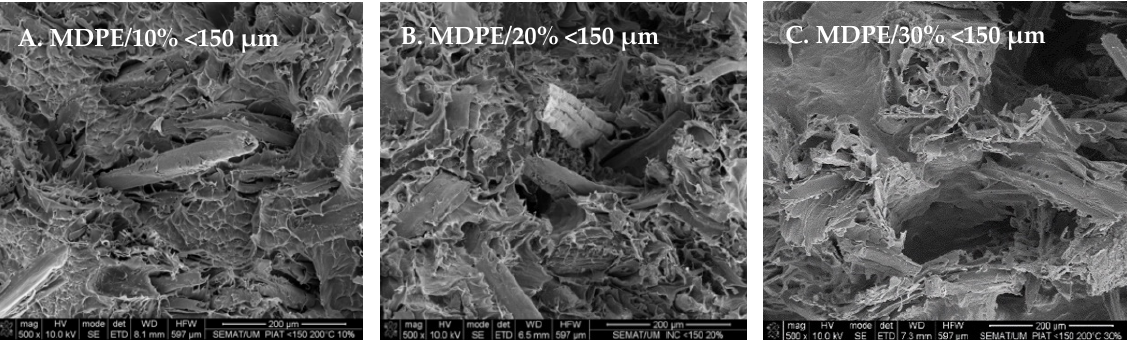
Figure 10. Effect of wood content on the morphology of MDPE/wood composites, with wood granulometry of <150 µm.